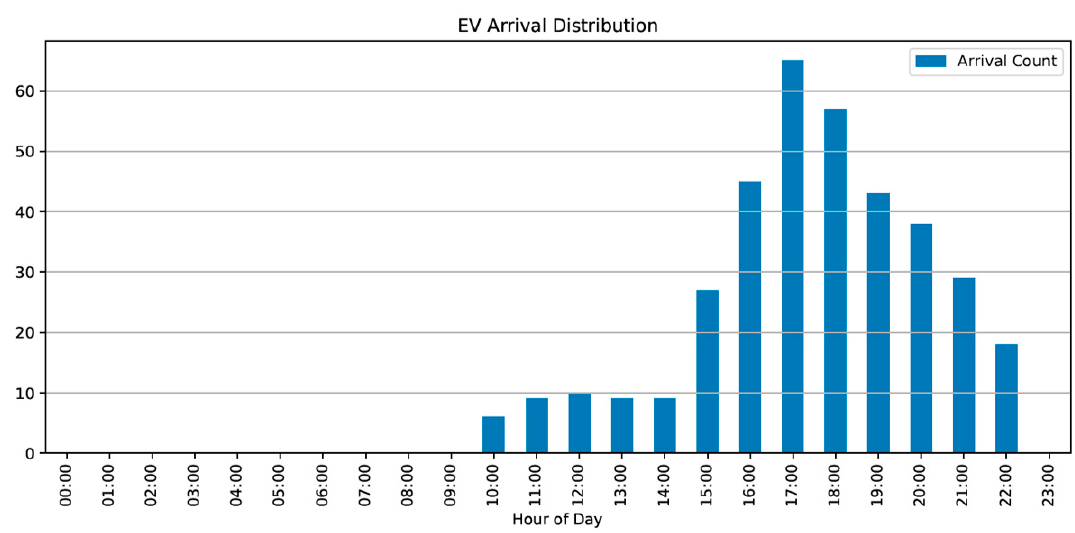
Figure 3. Yearly distribution of electric vehicle arrival hours.